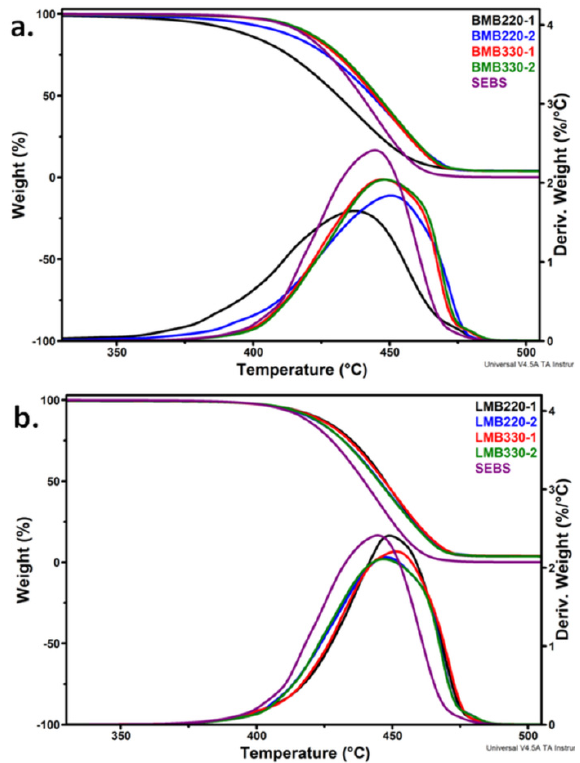
Figure 2. TGA and DTG curves of masterbatches obtained with Brabender ( a ) and Leistritz ( b ) extruders. Table 2. Characteristic temperatures and residue at 700 ◦ C for SEBS, HNT-QM and masterbatches.